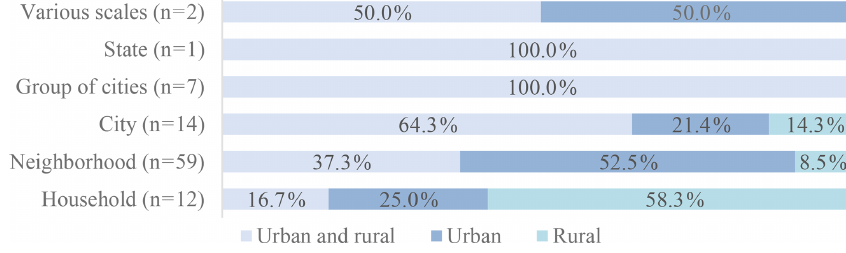
Figure 4. Classification of studies in terms of rural and urban areas and spatial